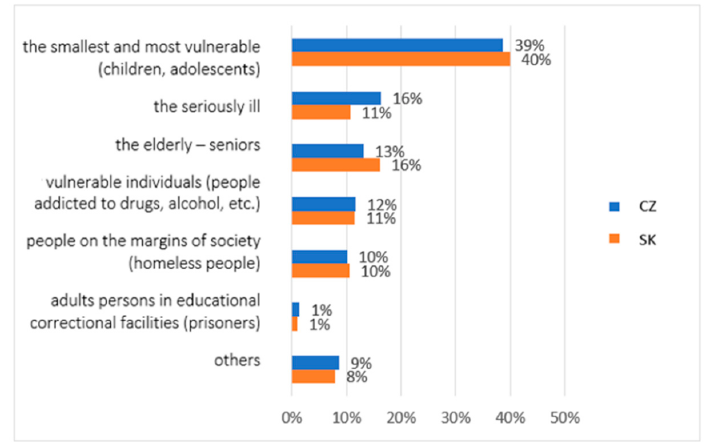
Figure 2. Descriptive statistics of the participants’ subjective perception of social and pastoral service (comparison of the healthy population of eastern Slovakia and north-western Czech Republic). Legend: CZ—healthy population of north-western Czech Republic, SK—healthy population of eastern Slovakia. Source: own resource.